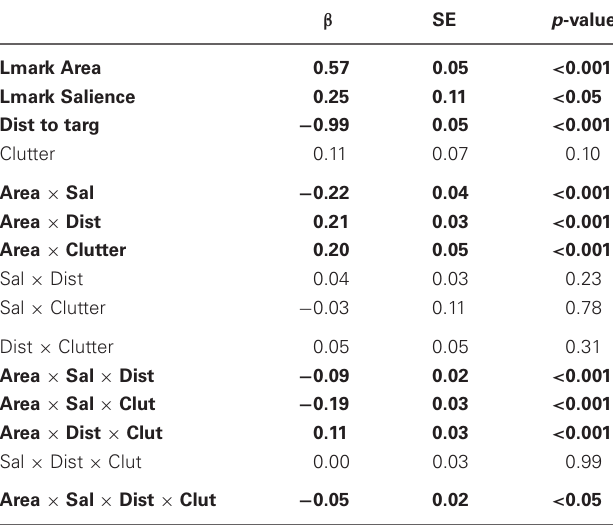
Bolding indicates main effects or interactions that reached